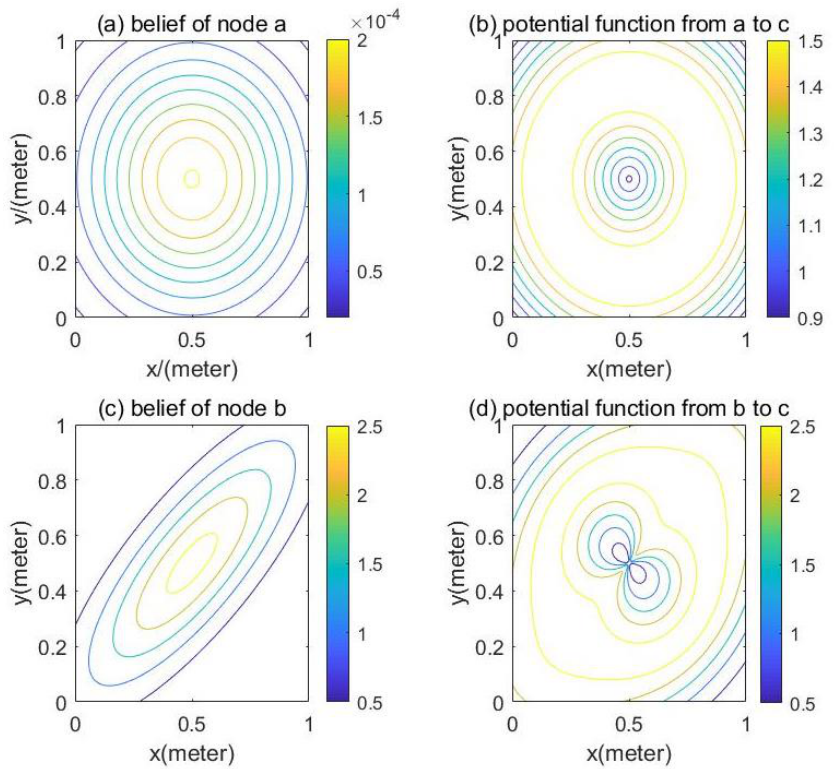
Figure 3. Node potential function under different distributions. ( a ) indicates belief of node a ( N a ), where µ = [ 0.5,0.5 ] , σ = [ 0.1,0.1 ] , ρ = 0; ( b ) indicates the potential function Ψ ac with dis ac = 0.35; ( c ) indicates belief of node b ( N b ), where µ = [ 0.5,0.5 ] , σ = [ 0.1,0.1 ] , ρ = 0.8; ( d ) indicates the potential function Ψ bc with dis bc =